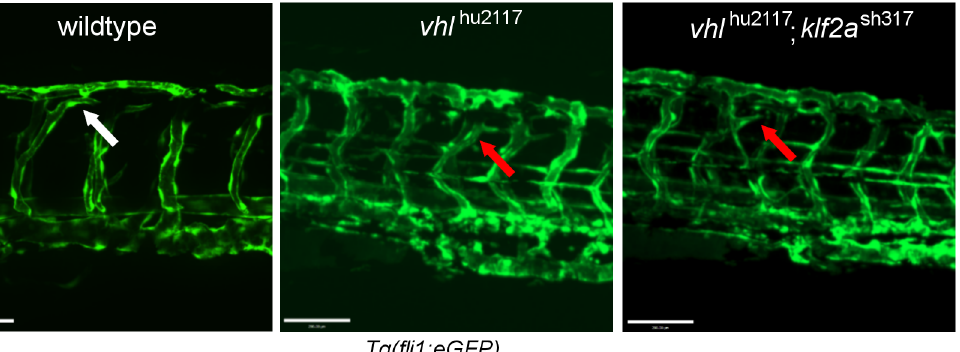
Fig 6. Vascular development in vhl hu2117 mutants is unaffected by the klf2a sh317 mutation. Wildtype embryos exhibit angiogenesis typical for this developmental stage – 3dpf (left figure, white arrow). Homozygous vhl hu2117 embryos show enlargement of vessels (ISVs and DLAV) with increased tortuosity and looping of the DLAV (middle figure, right arrow). The same vascular phenotype was be observed in vhl hu2117 embryos in a homozygous klf2a sh317 background (right figure, red arrow). Confocal images of Tg ( fli1 : eGFP) zebrafish embryos at 3dpf.. Scale bar = 70 μ m.